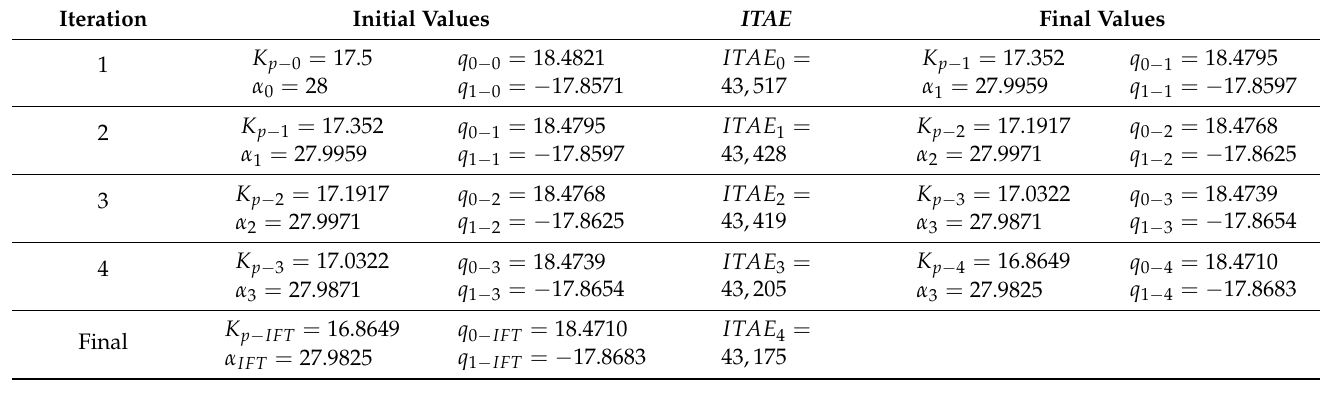
Table 2. Tuning parameters for the iP 1 controllers and the ITAE criteria values.